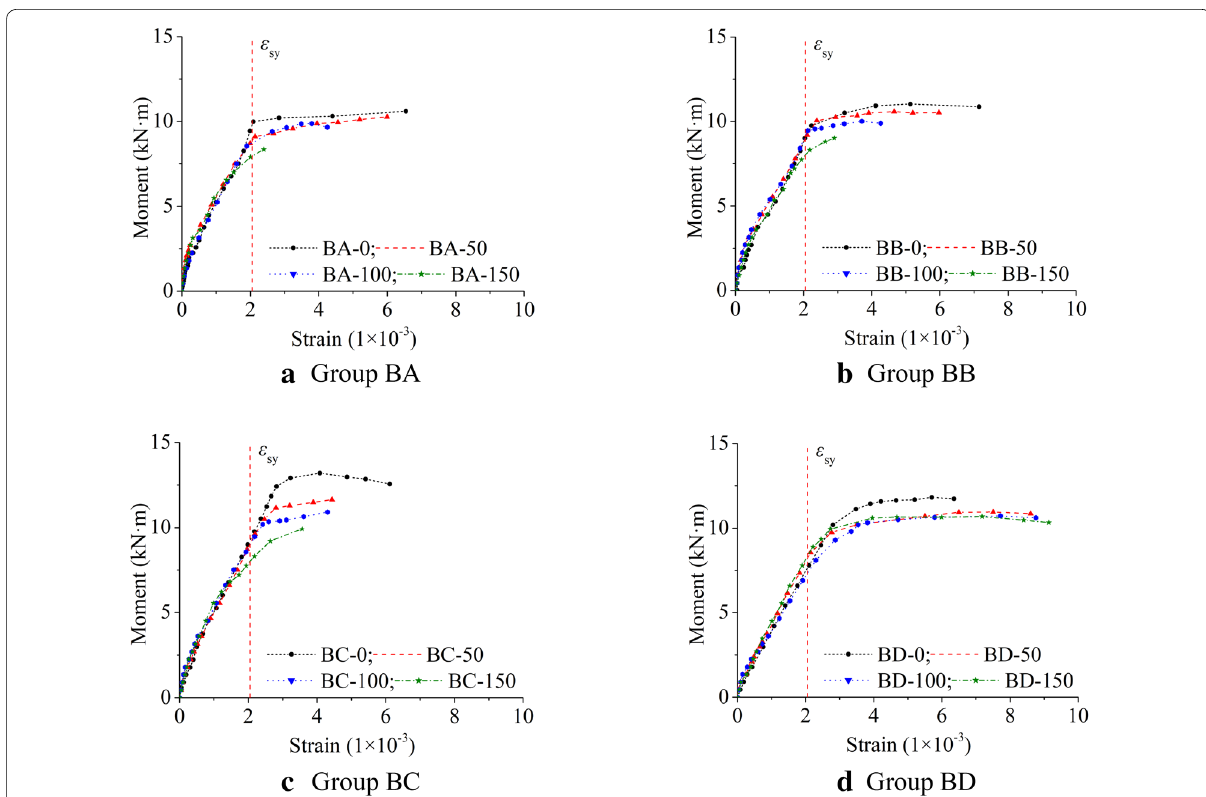
Fig. 4 Effect of freeze–thaw cycles on moment-strain